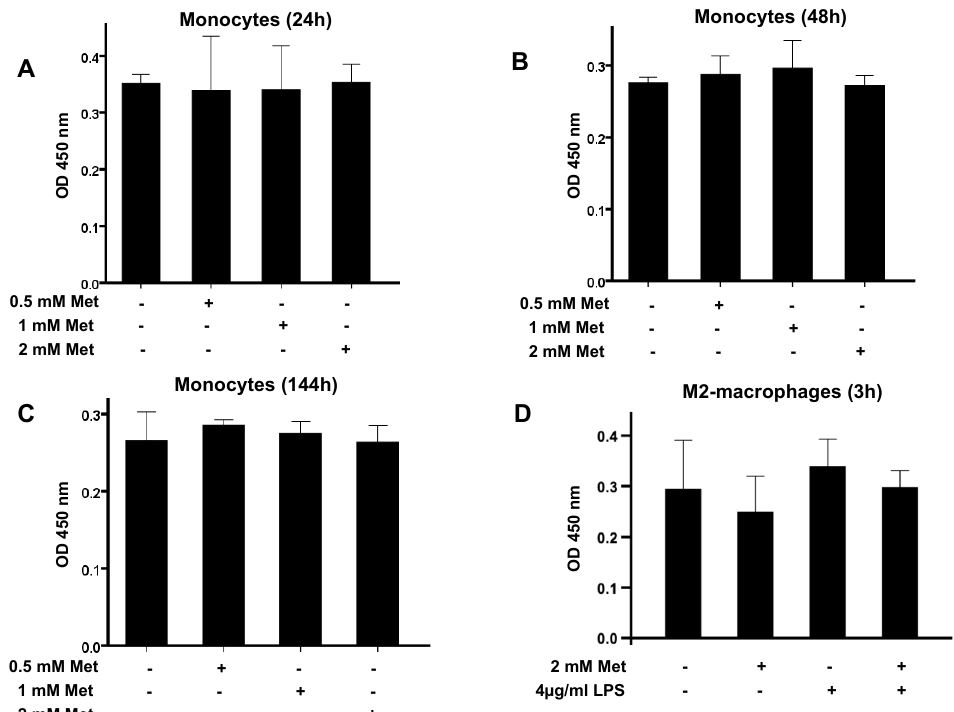
Figure 3. Evaluation of the cytotoxic effects of metformin on monocytes and M2 polarized macrophages. Human monocytes ( A – C ) and M2 macrophages ( D ) were incubated in the absence or the presence of metformin (0.5, 1, and 2 mM) for different indicated time periods. Cytotoxicity was analyzed after the addition of cytoX reagent and measurement of absorbance at 450 nm. Data are mean of absorbance ± SD (n = 3).